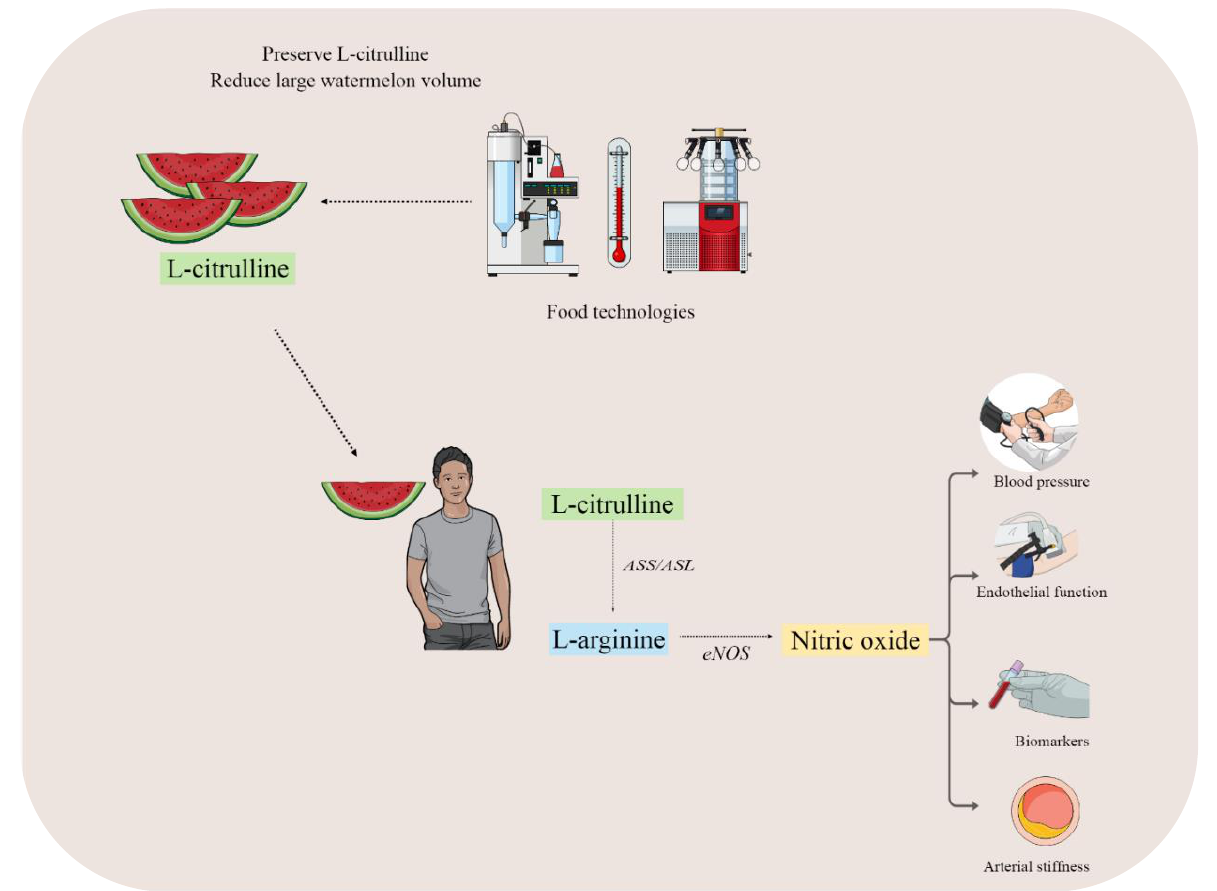
Figure 1. After watermelon ingestion, L-citrulline can be converted into L-arginine by argininosuccinate lyase (ASL) and argininosuccinate synthase (ASS), increasing plasma L-arginine level, which can be converted into nitric oxide (NO) in endothelial cells. Thus, NO can improve vascular health parameters, such as blood pressure, endothelial function, arterial stiffness, and biomarkers. How- ever, due to the large watermelon volume needed to achieve the effective L-citrulline dosage, food technologies are warranted to produce watermelon products with higher L-citrulline content.